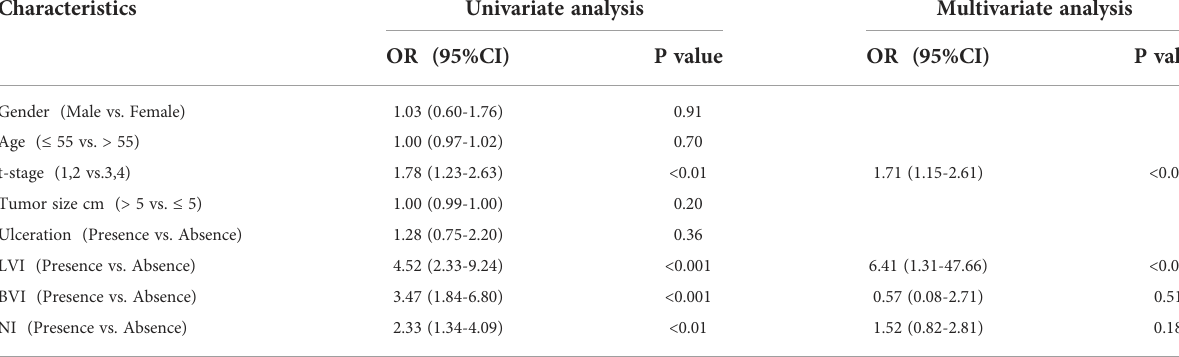
TABLE 3 Univariate and multivariate logistic regression analyses associated with